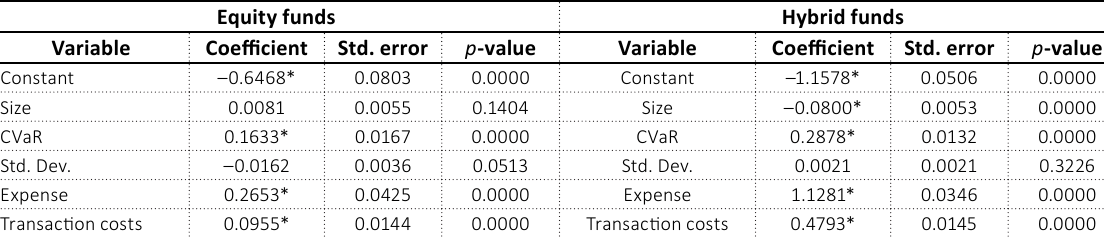
Table 5. Results from the censored Tobit